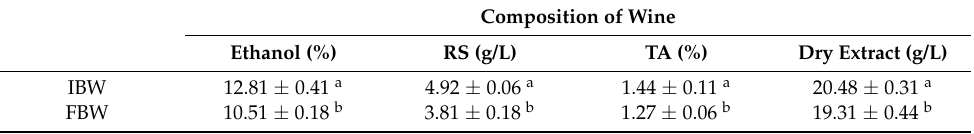
Table 1. General composition of Chinese bayberry